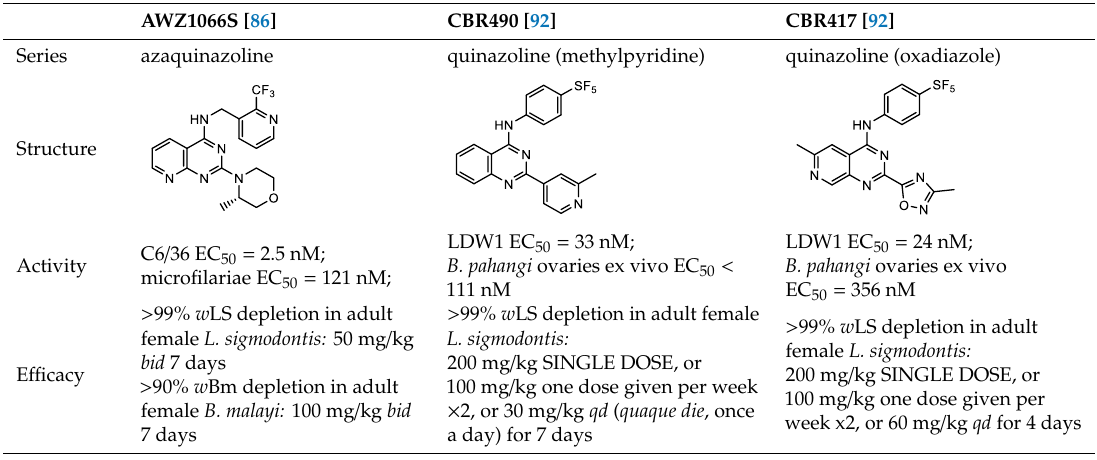
Table 7. Advanced novel small molecules optimized for antiwolbachial efficacy.